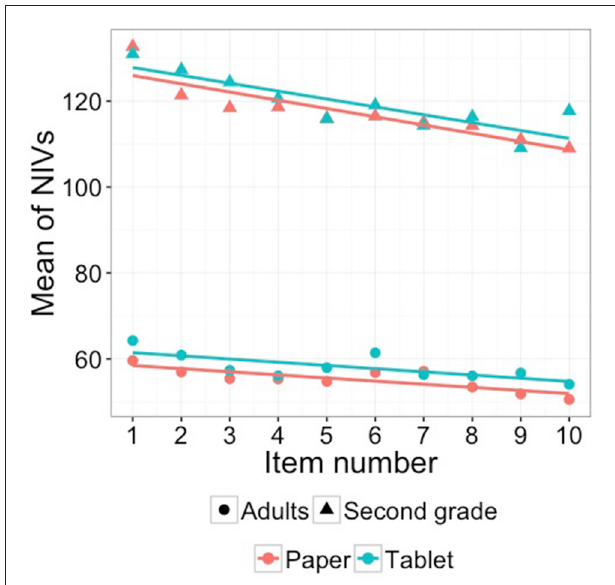
FIGURE 6 | The mean of the NIVs for each item of “sun and waves” on paper and on the tablet computer (with 95% confidence